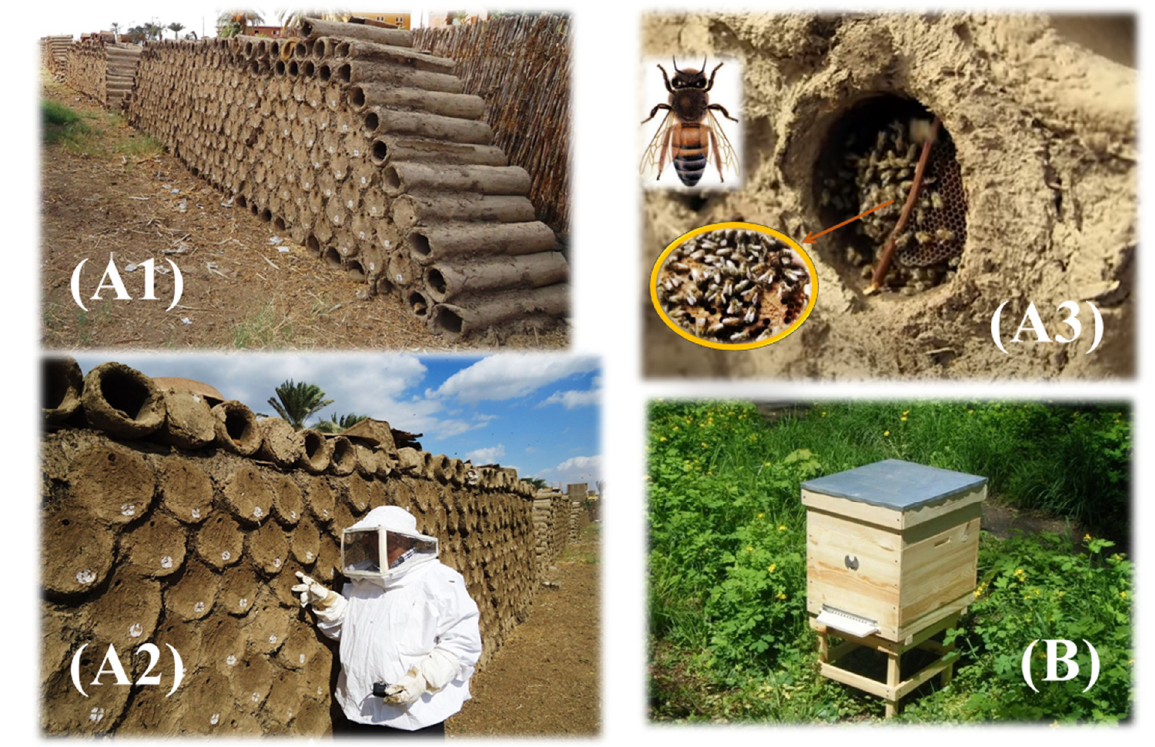
Figure 2. Beekeeping reliefs from the tomb of Pabasa and Karnak Temple (Photography by Aida Abd El-Wahed).